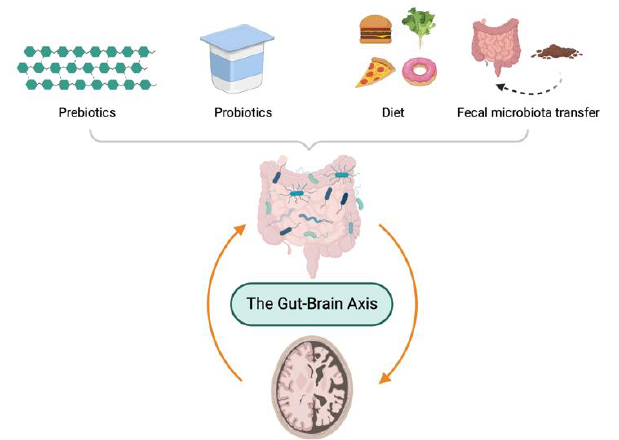
Figure 3. Gut microbiota-directed therapeutic options to ameliorate pathology of Alzheimer’s disease.